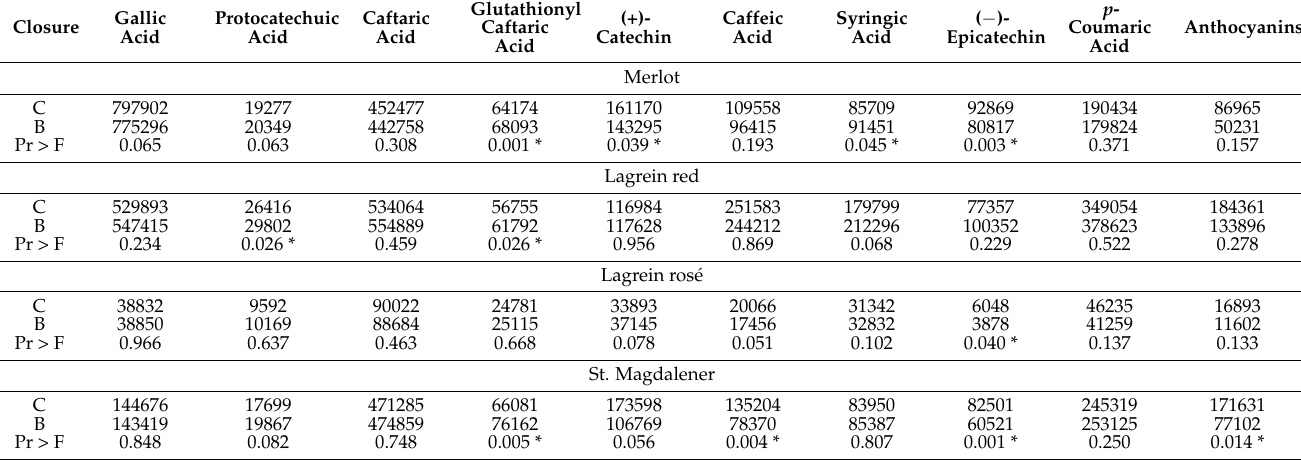
Table 4. One-way ANOVA of the phenolic compounds found in each type of wine closed with both types of closure (closure effect). Pr > F indicates the p -value associated with the F statistic. The asterisk (*) means significantly differences determined by Tukey’s test ( α < 0.05). B and C: blend and conventional closure,